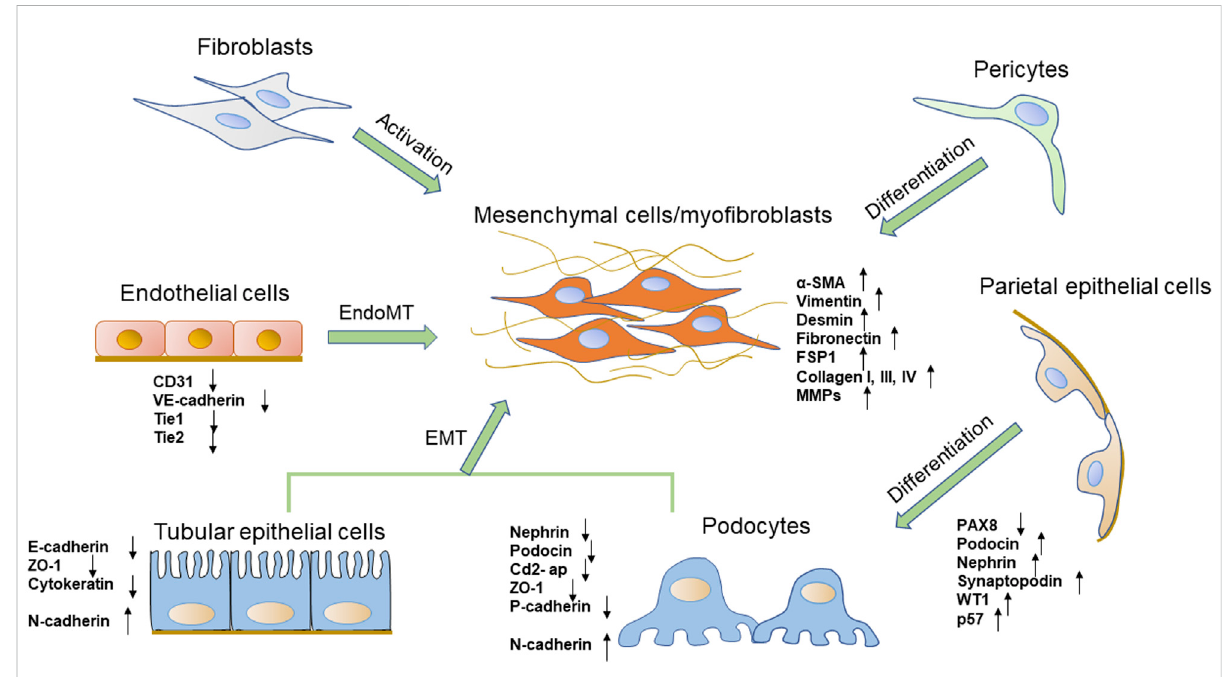
FIGURE 1 Thephenotypictransitions ofseveral types ofrenalcells andtheexpressions ofmarkers. Theorigin ofthemyo fi broblastsincludesseveraltypes of cells, such as fi broblasts, pericytes, tubular epithelial cells, and endothelial cells. Podocytes also obtain a mesenchymal property through mesenchymal transition. PECs are one of the possible sources of